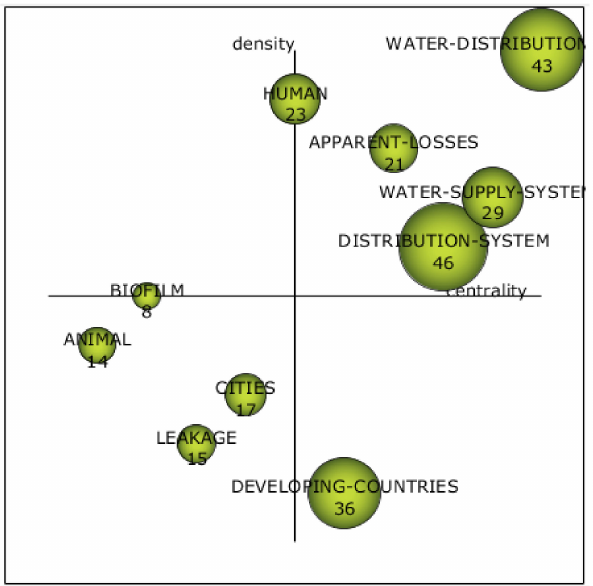
Figure 12. The strategic diagram depicts the number of published works and combines the different themes of IWSS research at the global